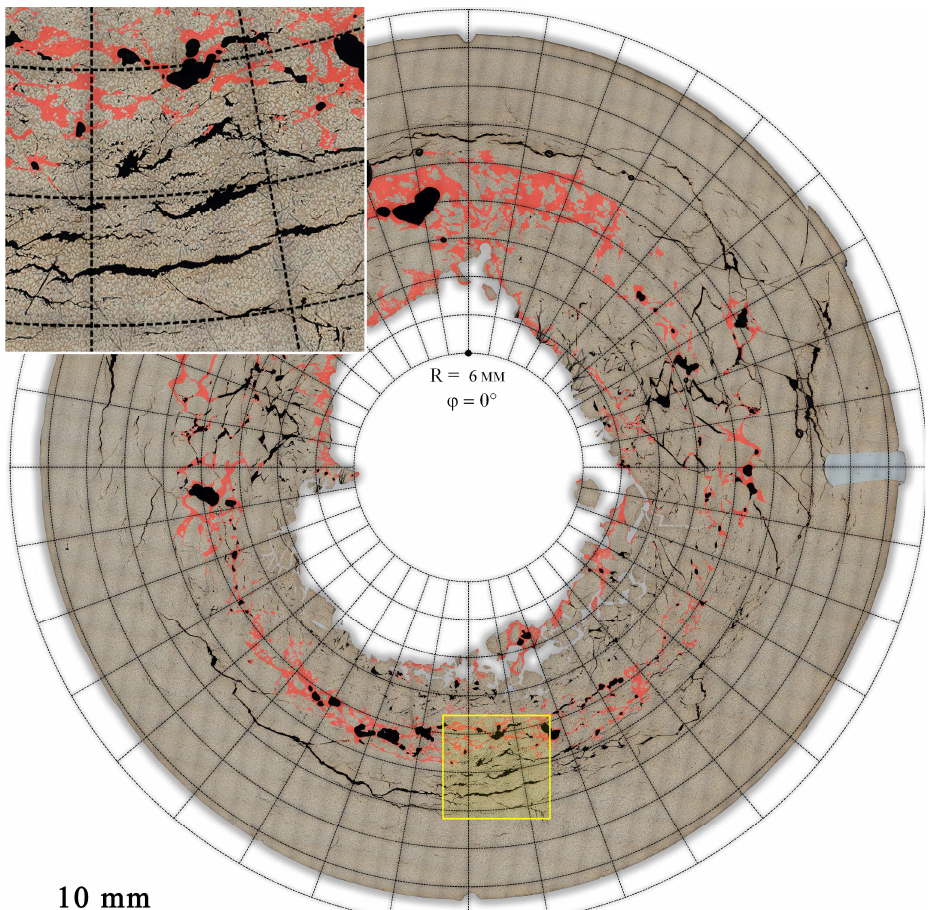
Fig. 3. General view of fractures revealed on the polished surface of the meridional cross- section of the shell. Northern pole is on top. PiP: fractures localization at radii R ≈ 13…16 mm and R ≈ 16…19